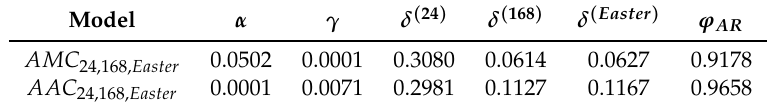
Table 3. Smoothing parameters for the models used to predict the days of Easter in 2014 and 2015.